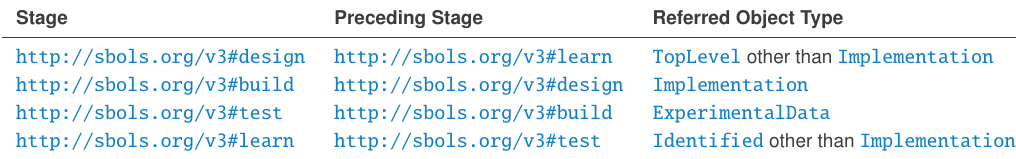
Table 21: Ordering of design-build-test-learn stages, and the types of objects RECOMMENDED to be associated with